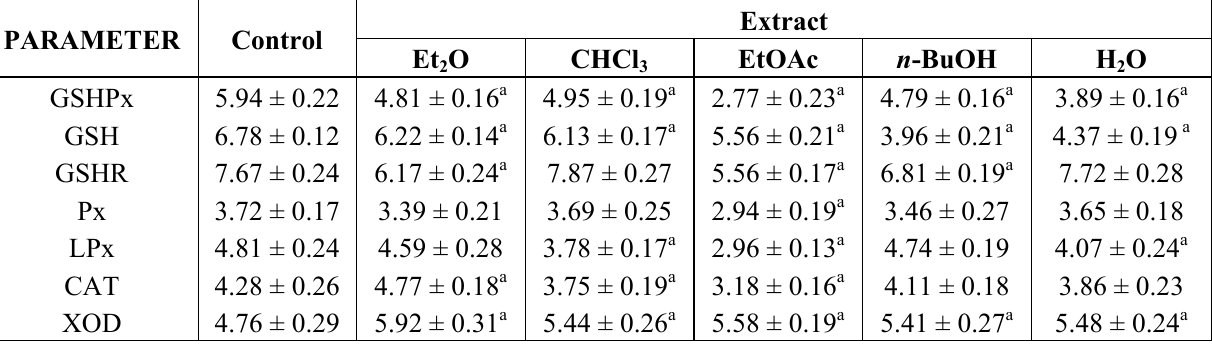
Table 5. Effect of extracts of M. melissophyllum leaves on the biochemical parameters in blood